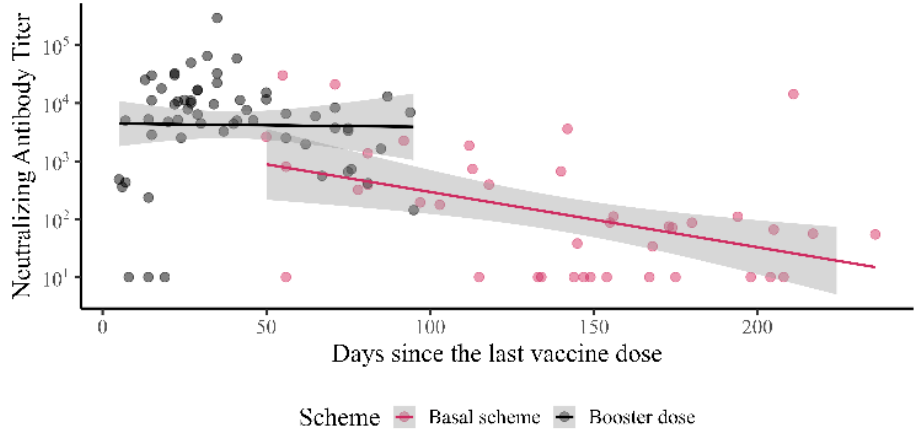
Figure 3. Scatter plot showing the relationship between nAbs titers and time, using days since the last vaccine dose.